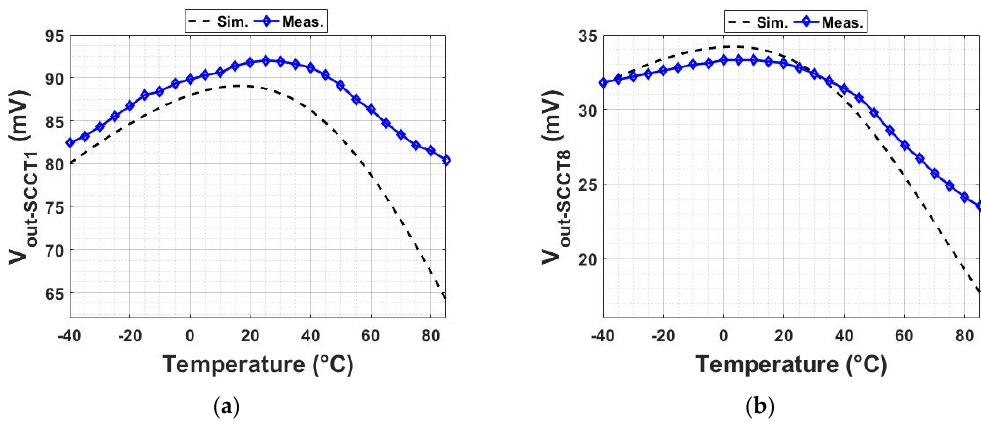
Figure 4. Measured output voltage as a function of temperature for the ( a ) SCCT1 and ( b ) SCCT8 using I Bias of 100 nA.